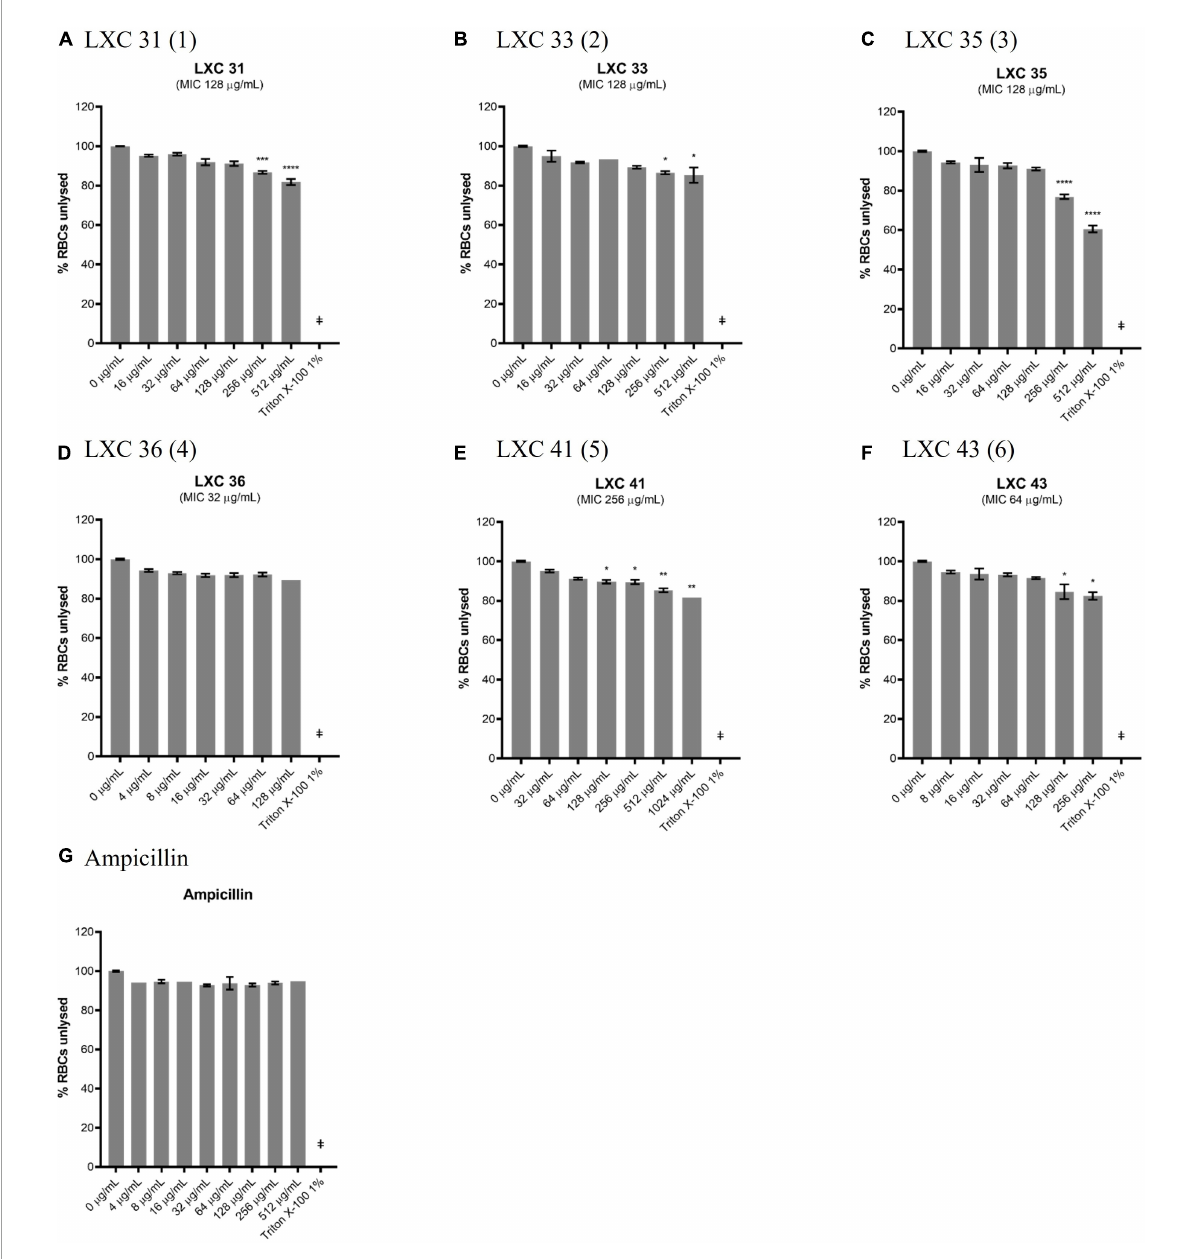
FIGURE9 Most of the LXC compounds are not hemolytic up to 128 µ g/mL. (A–G) Freshly washed human RBCs in PBS solution (137 mM NaCl, 2.7 mM KCl, 1.46 KH 2 PO 4 , 8.1 mM NaH 2 PO 4 , pH 7.4) was exposed to 8 µ L of LXC compounds with concentrations ranging from 0 µ g/mL up to 4 × their MIC values in 2.0% (v/v) DMSO. A 1% (v/v) Triton X-100 was used to indicate complete RBC lysis ( ‡ ). Ampicillin (0–512 µ g/mL) was used as a control or drug that does not cause RBC lysis. The assays were performed in quadruplicates. The plates were incubated at 37 ◦ C while constantly shaking at 100 rpm for 1 h. Intact RBCs were removed by centrifugation and the presence of hemolytic products in the supernatant were determined by measuring the absorbance at A 450 nm. The results are presented in mean ± SEM. Statistical analysis was performed using one-way ANOVA and the asterisks (*) represent statistical significance (* p < 0.05; ** p < 0.005; *** p < 0.0005; **** p <